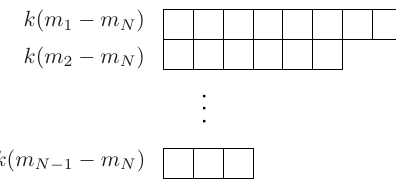
Figure 8 . SU( N ) representation of an SU( N ) monopole in the presence of a level k CS term. reduction of the magnetic one-form Z N symmetry of the 4d theory, and can be seen for example from (cid:25) 1 (SU( N ) = Z N ) = Z N . In the presence of a level k CS term (A.4) the new monopoles transform simply as the symmetric mk -fold product of fundamentals ( N mk ) sym